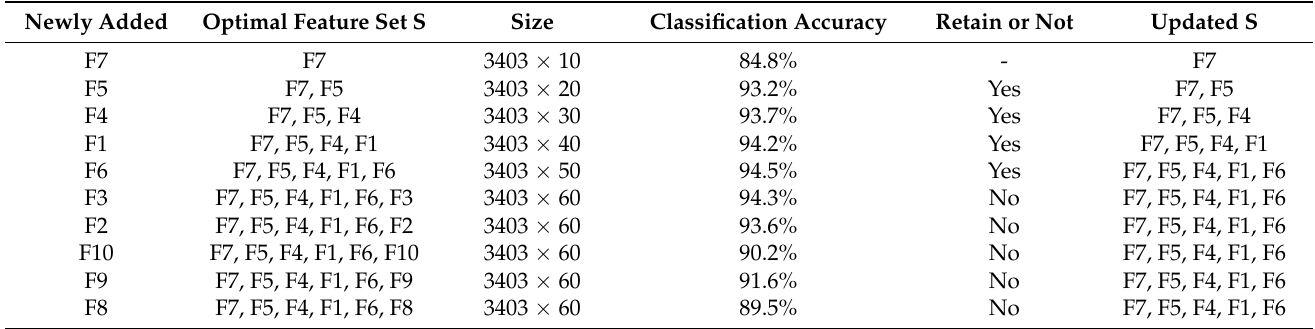
Table 6. Steps for updating the optimal feature set and the classification accuracy associated with each